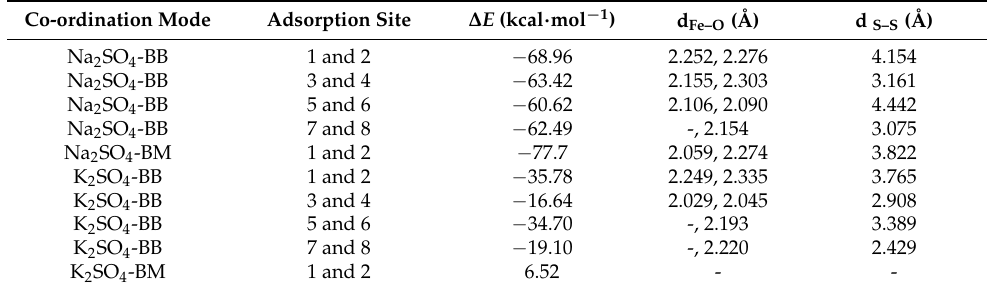
Table 3. Adsorption energies for metal sulfates adsorption at different sites on the (001)-S chalcopyrite surface. BB: bidentate binuclear; BM: bidentate